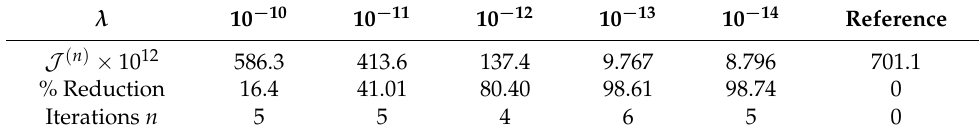
Table 3. Velocity matching case with Dirichlet boundary control. Case 1: objective functional, percentage reduction, and number of iterations of the optimization algorithm for different λ values.